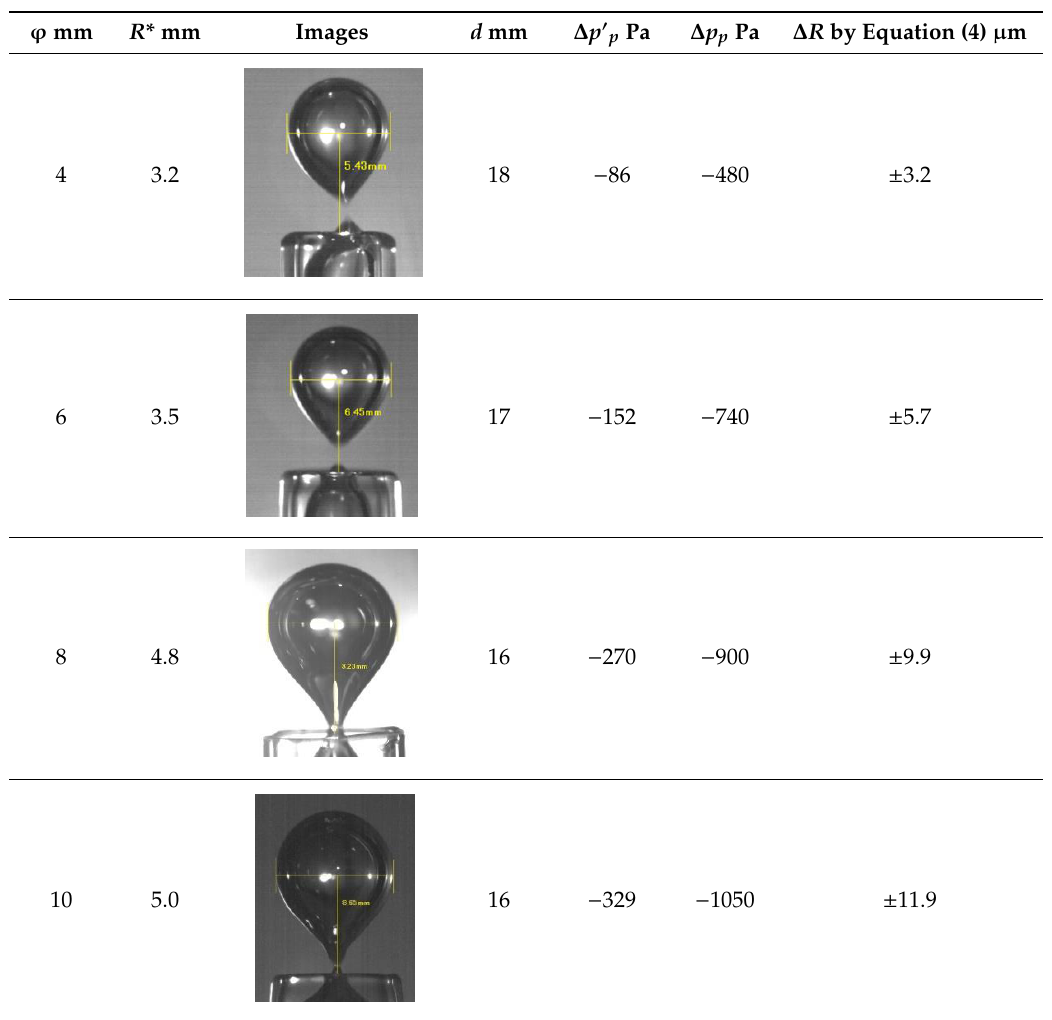
Table 2. Estimated pressure drop and radius variation.